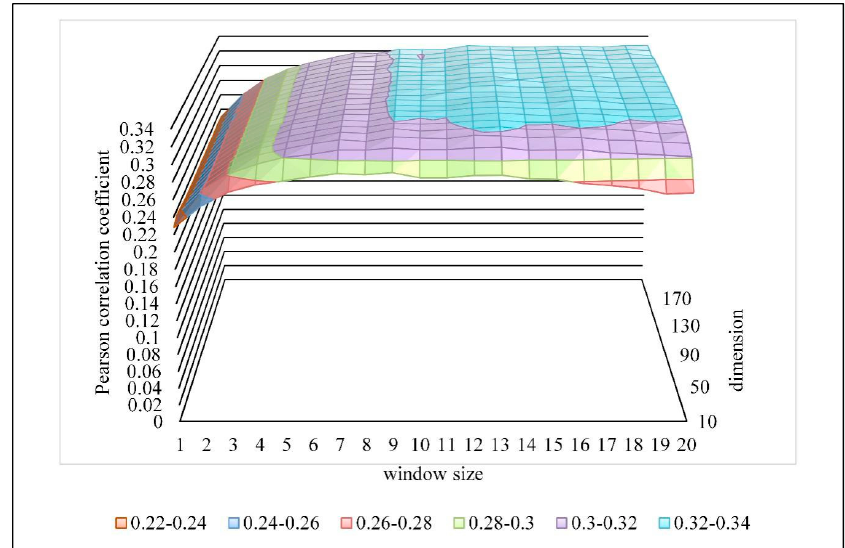
Figure 5. Parameter selection of the distributed representation of POIs. The X-axis is the window size, the Y-axis is the dimension, and the z-axis is the Pearson correlation coefficient corresponding to the first two. The different colors indicate the magnitude of the Pearson correlation coefficient.